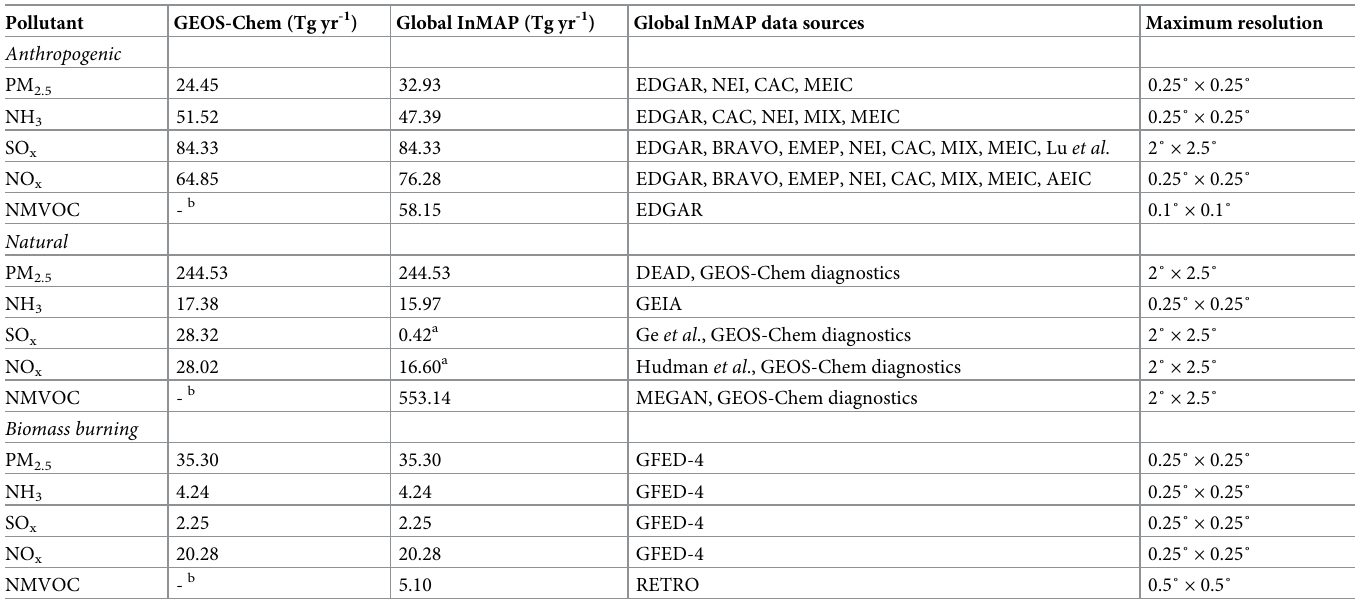
Table 1. PM 2.5 and precursor emissions inputs into GEOS-Chem and Global InMAP.